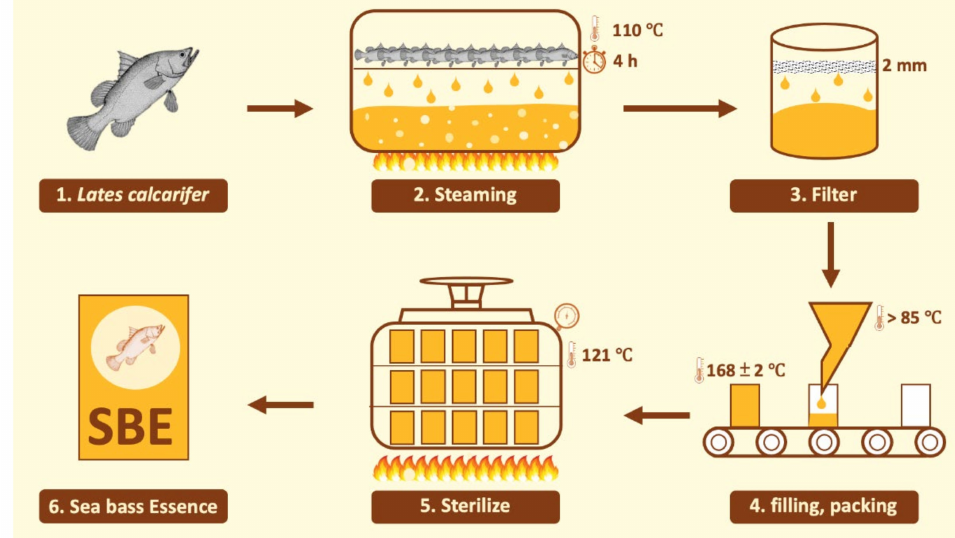
Figure 5. SBE production